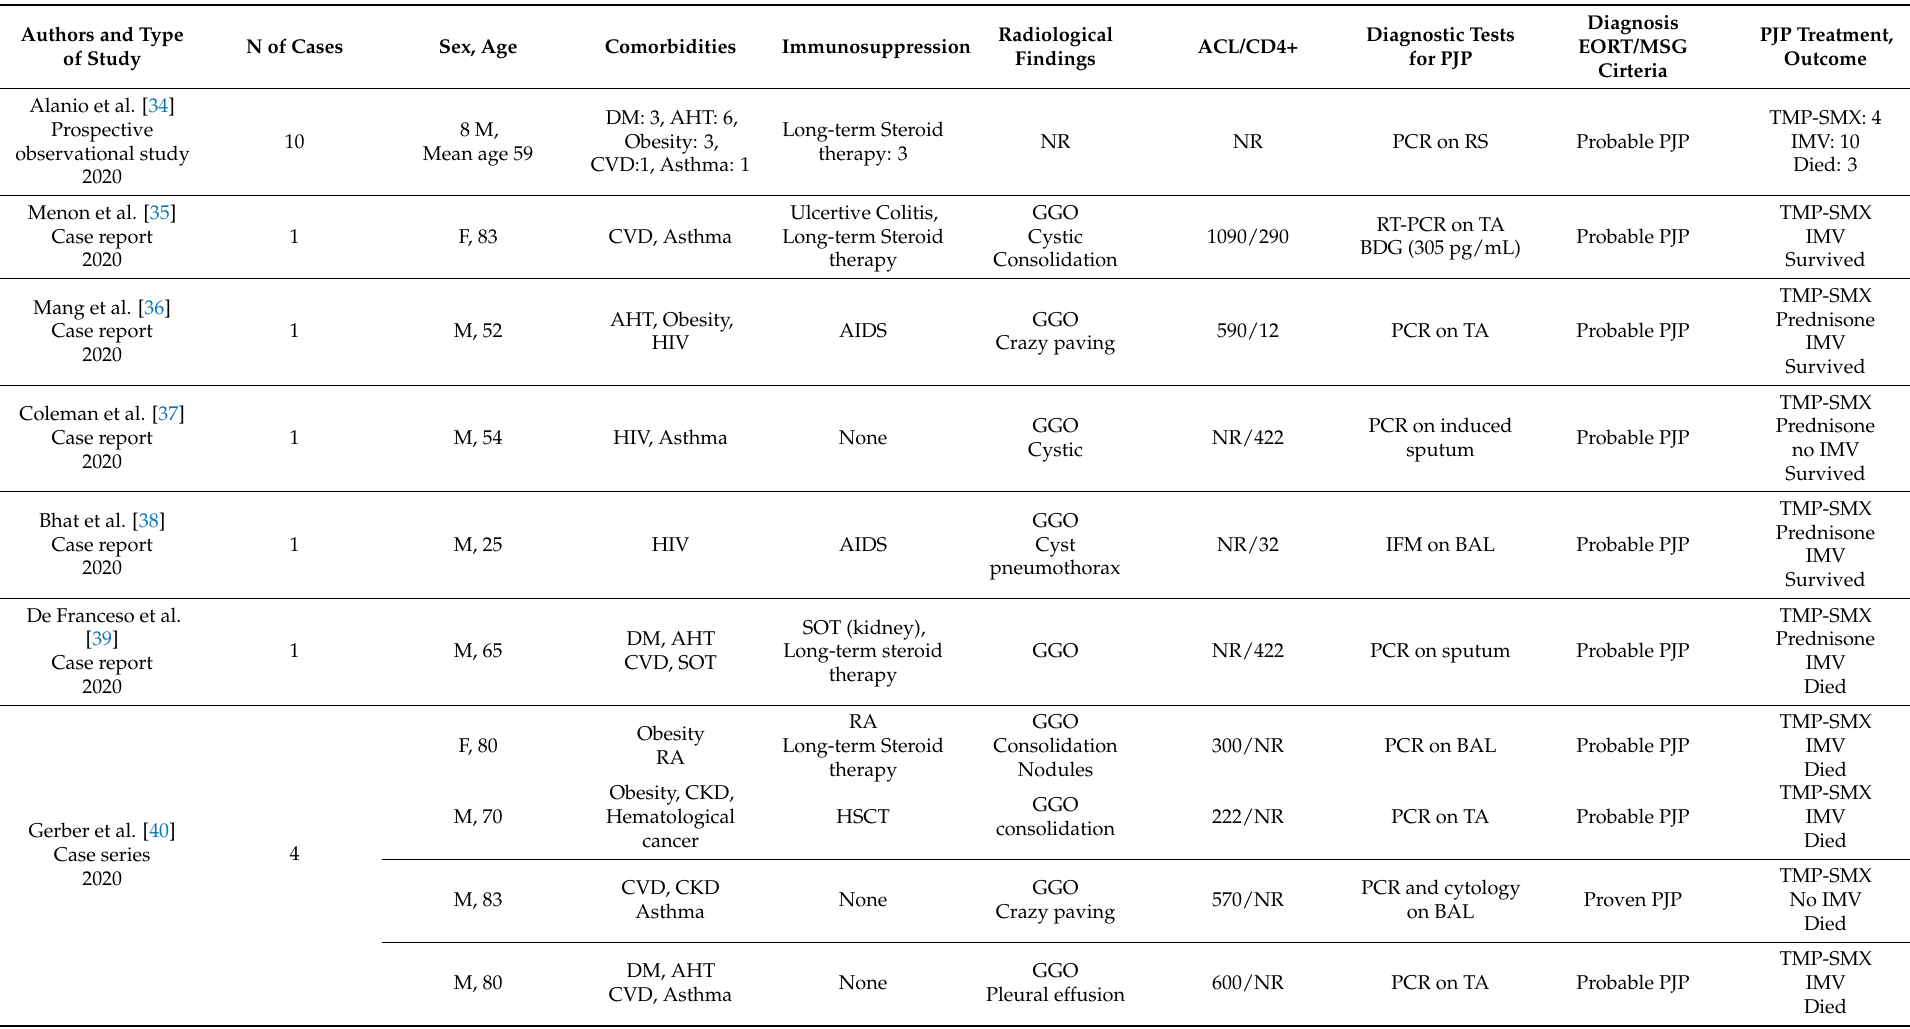
Table 1. Demographic and clinical characteristic of